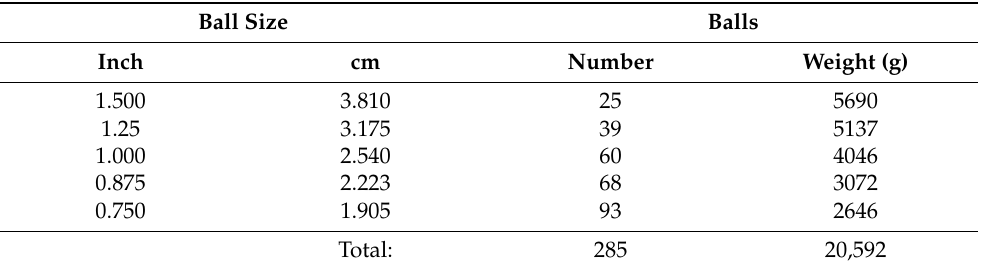
Table 2. Ball charge distribution used in this research.